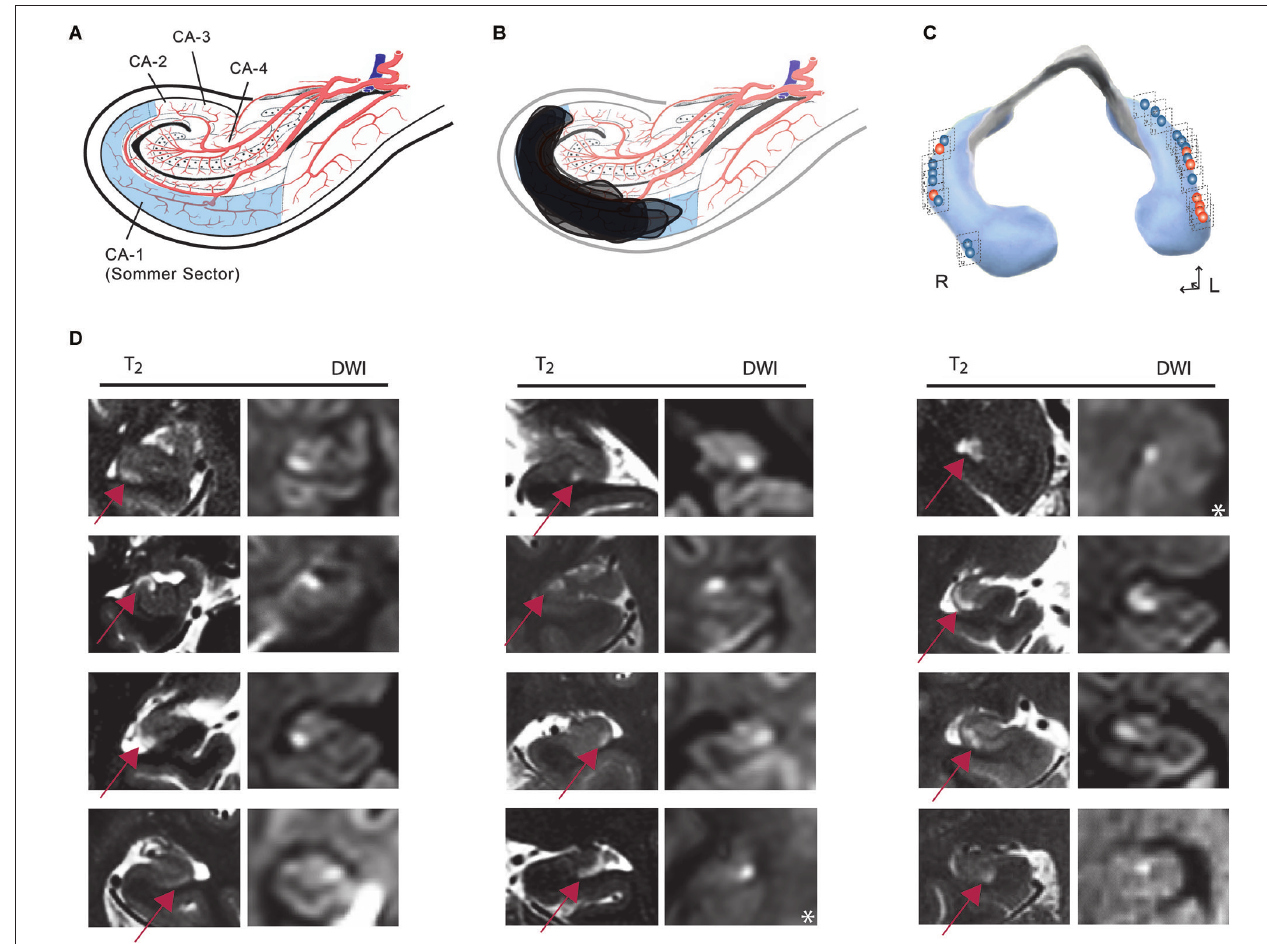
representative coronal MRI images of the hippocampus [T2/Diffusion- weighted images (DWI)] illustrating that lesions were confined to the CA1 area of the cornu ammonis. In each CA1 lesion, signal changes in diffusion-weighted and corresponding T2-weighted imaging can be observed. The arrow illustrates the CA1 lesions in T2 imaging. *DWI image in an axial plane.